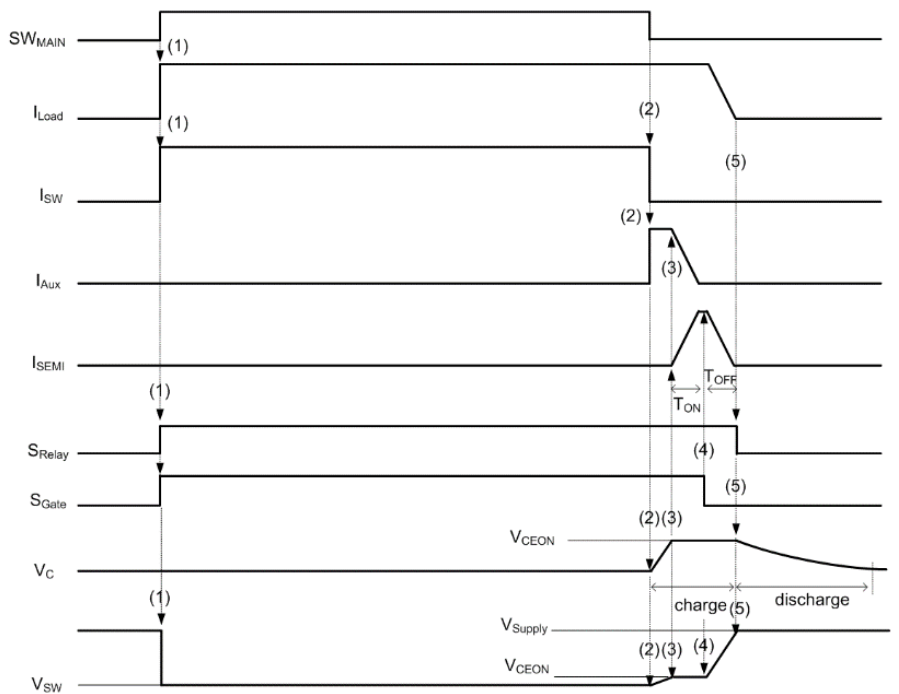
Figure 3. Switching sequence of the proposed MVDC hybrid circuit breaker.